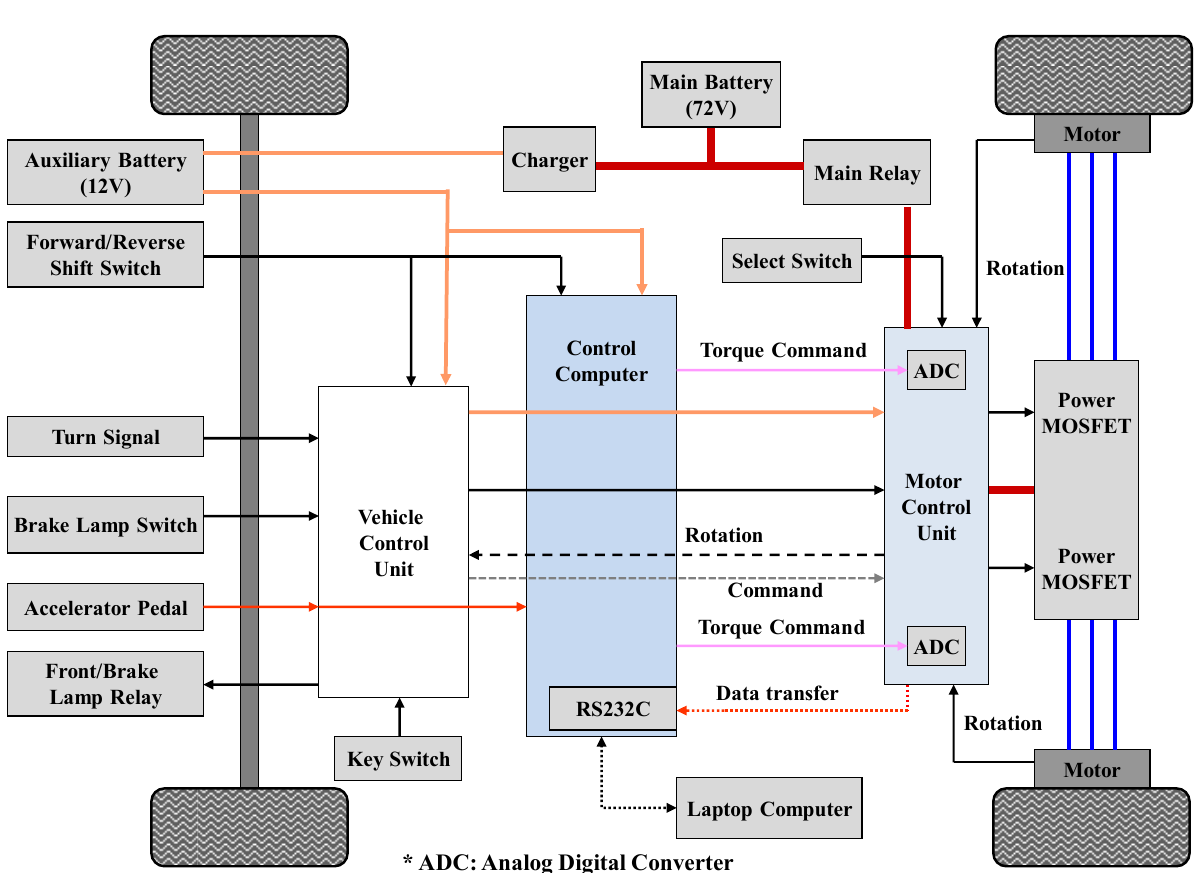
Figure 2. Schematic of the vehicle control system